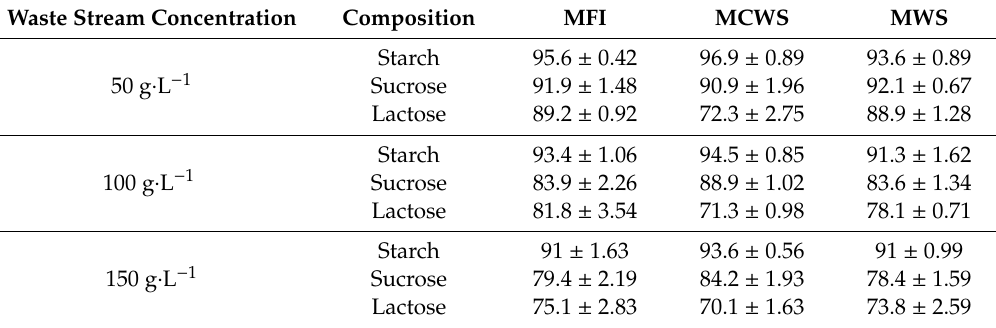
Table 1. Degree of hydrolysis (%, w / w) of starch, sucrose, and lactose during hydrolysis experiments, using varying initial solid concentrations of mixed food for infants (MFI), mixed confectionery waste streams (MCWS), and mixed waste streams (MWS) hydrolysates.